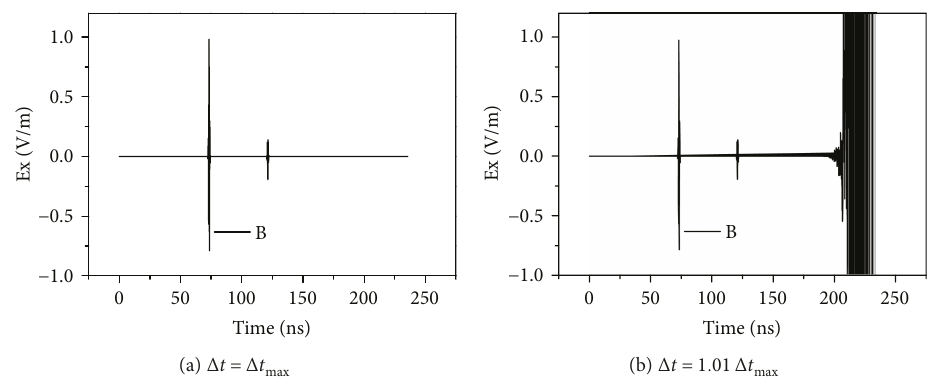
Figure 4: Waveform of E x at the observation